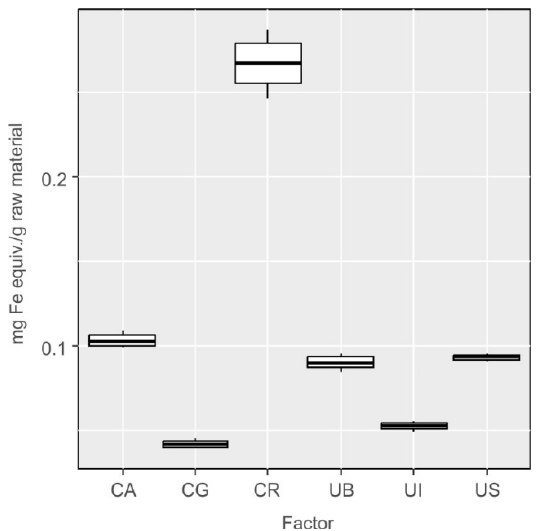
Figure 7. Results of determination of the content of compounds with antioxidant activity in extracts from Cladophora and Ulva species using the FRAP method, converted into milligram equivalents of iron per gram of raw material.